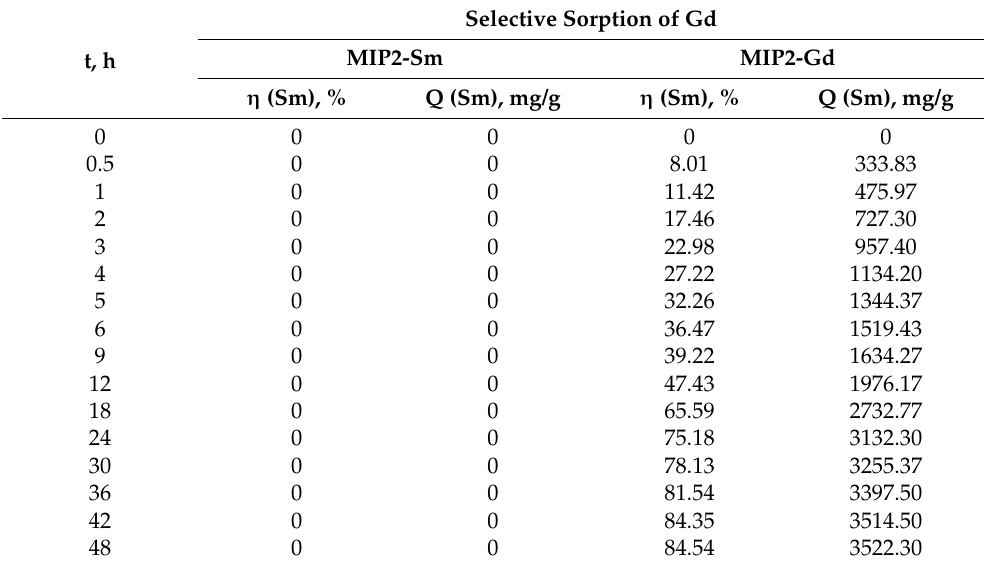
Table 11. Sorption properties of the MIP2-Sm and MIP2-Gd structures during selective sorption of